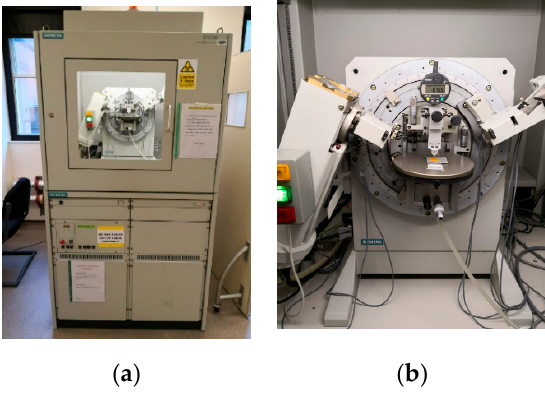
Figure 14. ( a – b ) XRD equipment with rust sample being tested. Table 2. Elemental composition (wt%) of corrosion product collected from colour coded plates. Colour Coded Plate